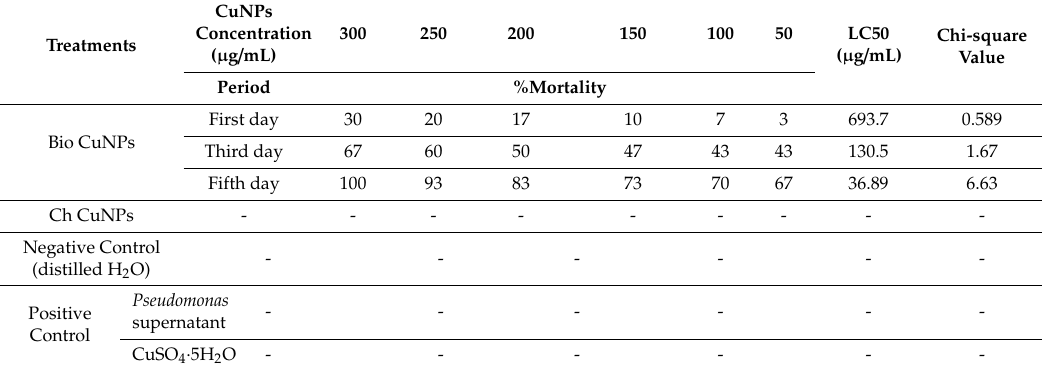
Table 1. Probit analysis for the data on adult mortality of Tribolium castaneum treated with CuNPs at 95% confidence